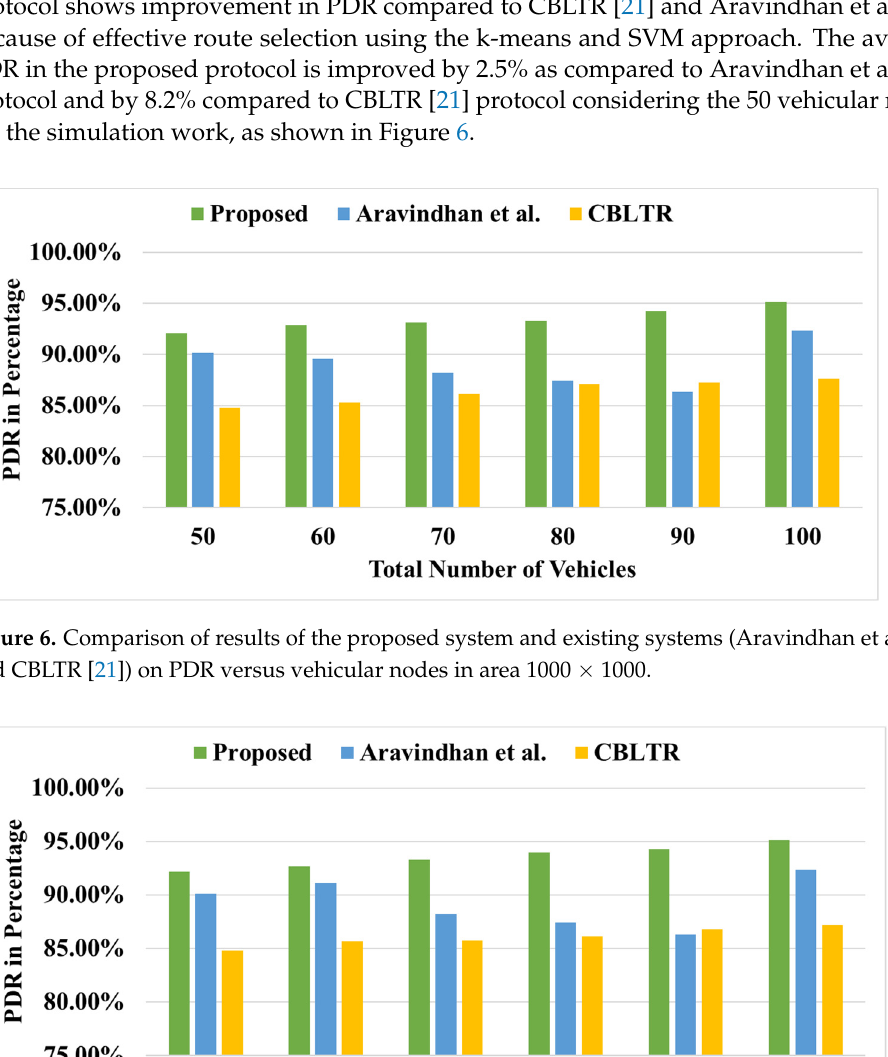
Figure 7. Comparison of results of the proposed system and existing systems (Aravindhan et al. [24] and CBLTR [21]) on PDR versus vehicular nodes in area 1200 × 1200.